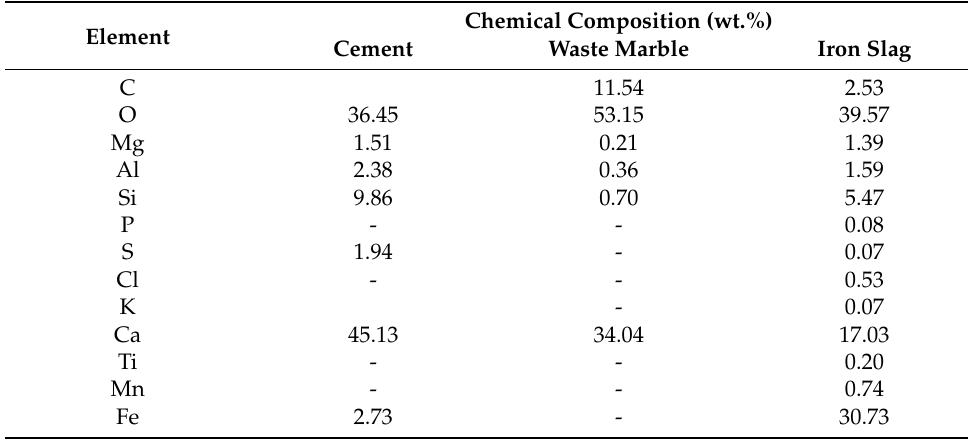
Figure 1. The utilized materials in powder form after sieving. Table 1. EDX analysis for cement, waste marble, and iron slag.